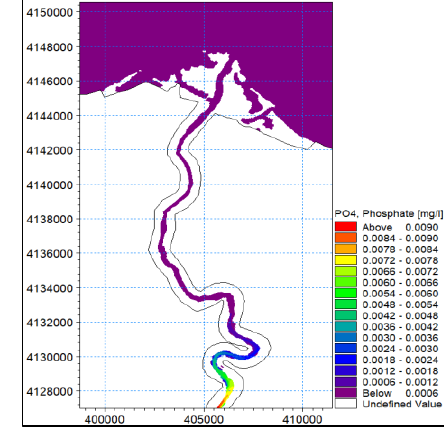
Fig. 5: Nitrate (NO 32- ) fluctuations tendency Fig. 6: Phosphate fluctuations tendency Table 1: ecological risk characterization and receptors sensivities by using TIER